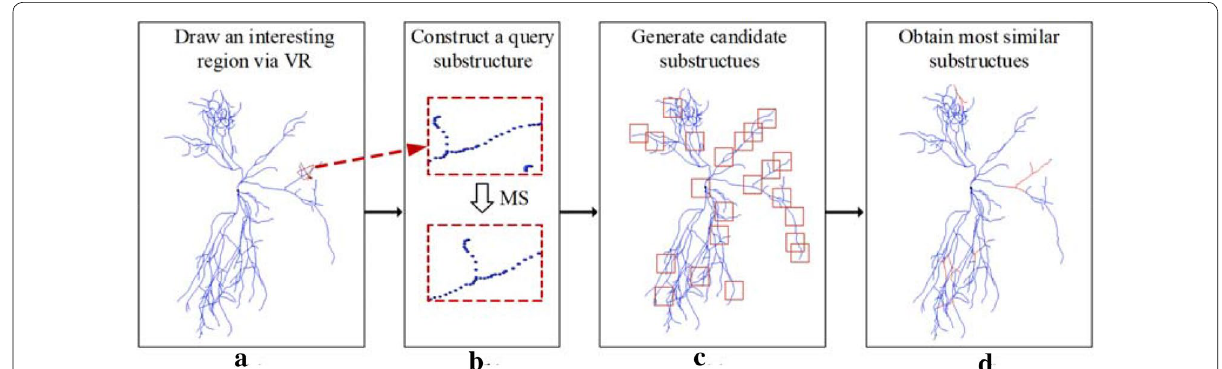
Fig. 2 The workflow of the proposed pipeline. a A reconstruction of a neuron and an interesting region (in red) on it which was drawn via VR plugged in Vaa3D. b The marked substructure in the interesting region (top), and its query substructures constructed by MS (bottom). c Some candidate substructures boxed on the reconstruction. d Some retrieved substructures (in red) demonstrated on the reconstruction, which are most similar to the